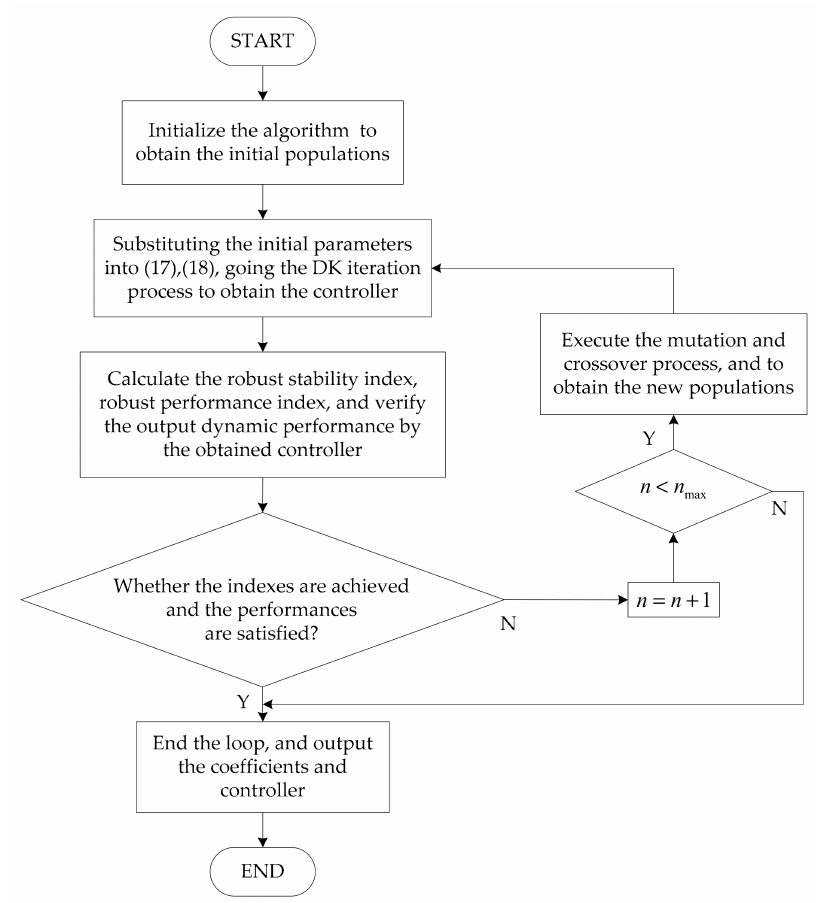
Figure 5. Flowchart of the proposed method.